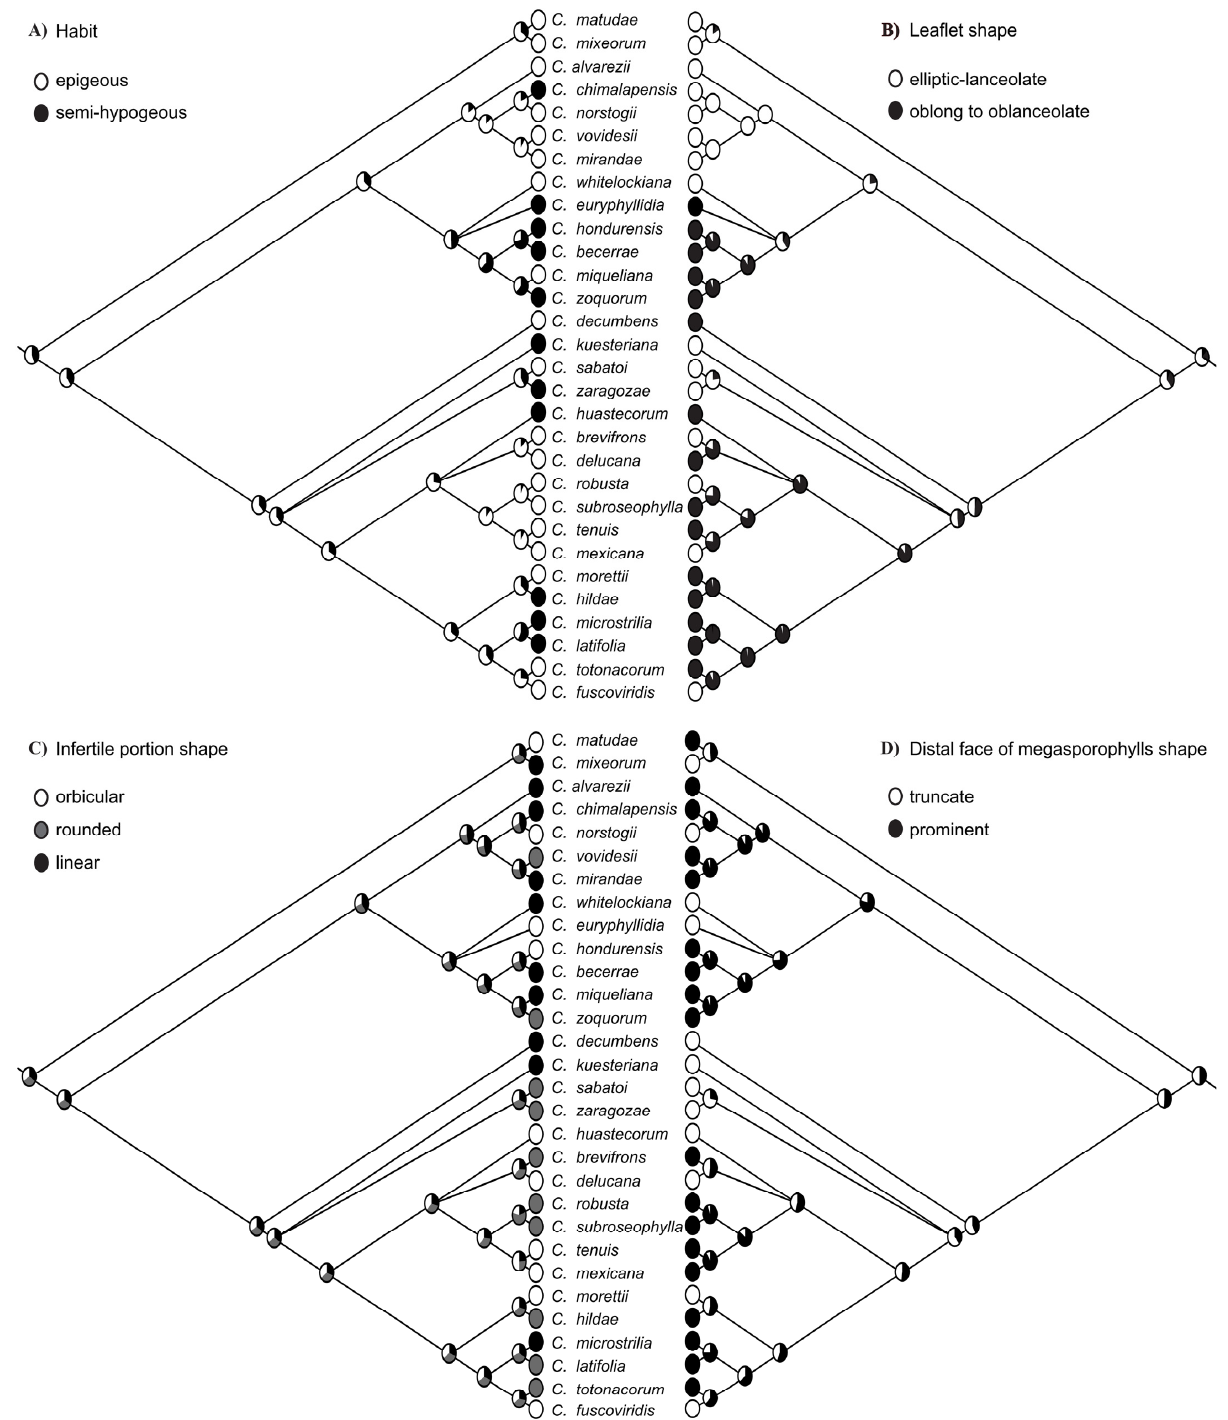
Figure 6. Optimization of key morphological characters based on the Mk1 model implemented in Mesquite. ( A ) Habit (character 1), ( B ) leaflet shape (character 2), ( C ) infertile portion shape (character 8), and ( D ) distal face of megasporophyll (character 11) inferred from the ML tree of the concatenated dataset with all codon positions included (nt dataset) and with poorly supported branches (BS < 85) collapsed.